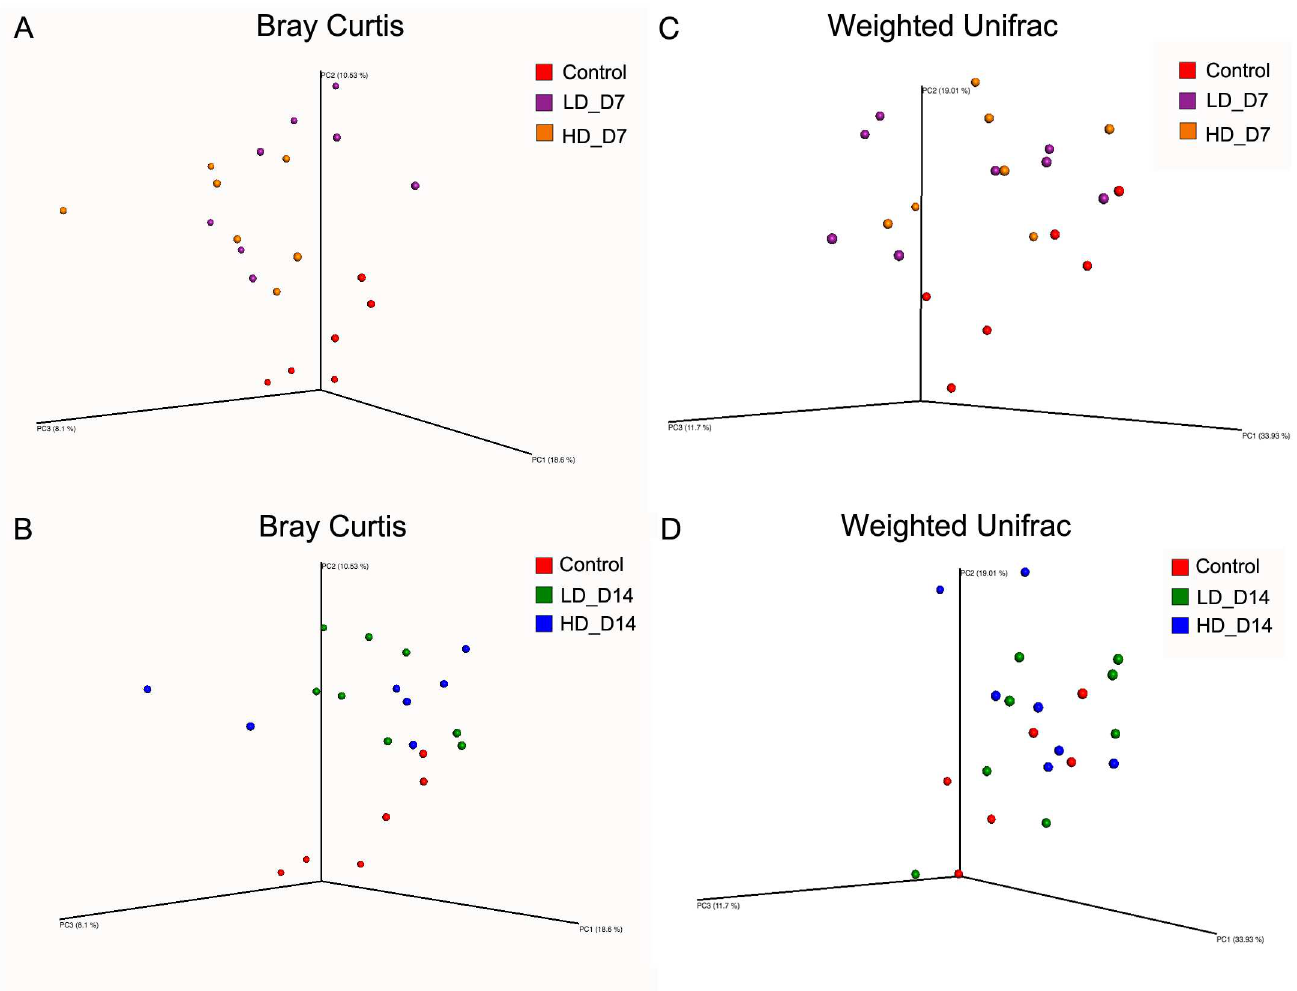
Fig 3. Three-dimensional principal coordinate analysis obtained with Bray Curtis distances (A and B) or weighted UniFrac distance matrix (C and D) of the salmon skin bacterial communities from day 7 infection (A and C) and day 14 infection (B and D). Each dot representsone individualfish. LD_D7: low-doseinfected day 7; LD_D14: low-doseinfected day 14; HD_D7: high-doseinfected day 7; HD_D14:high-doseinfected day 14.